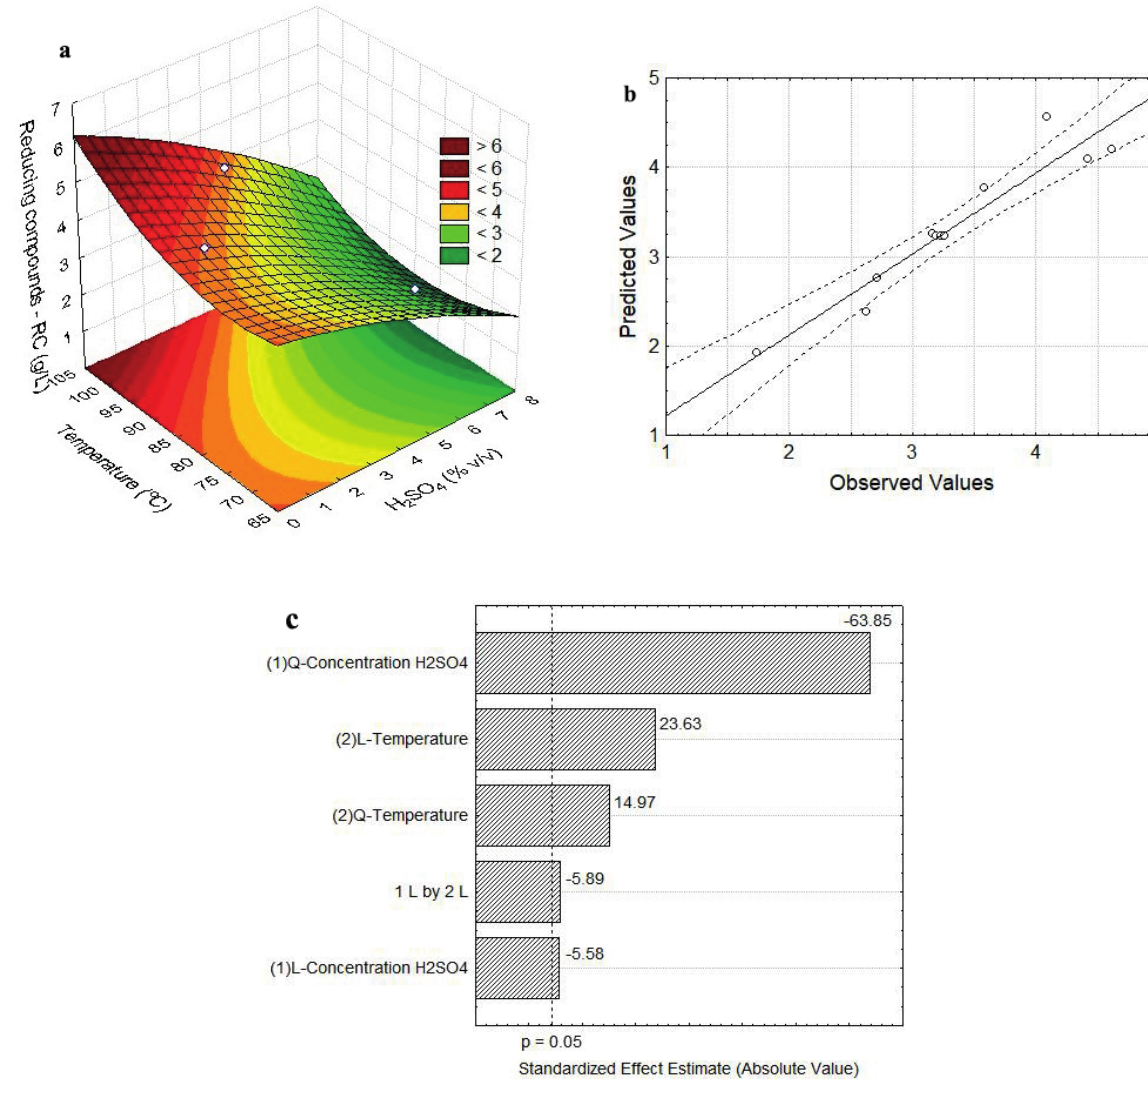
Figure 1 - experimental design to pectin acid hydrolysis optimization – response surface ( a ), distribution of residuals ( b ), and Pareto chart ( c ) as a function of independent variables: temperature and H2SO4 concentration, and response variable: reducing compounds (RCs)